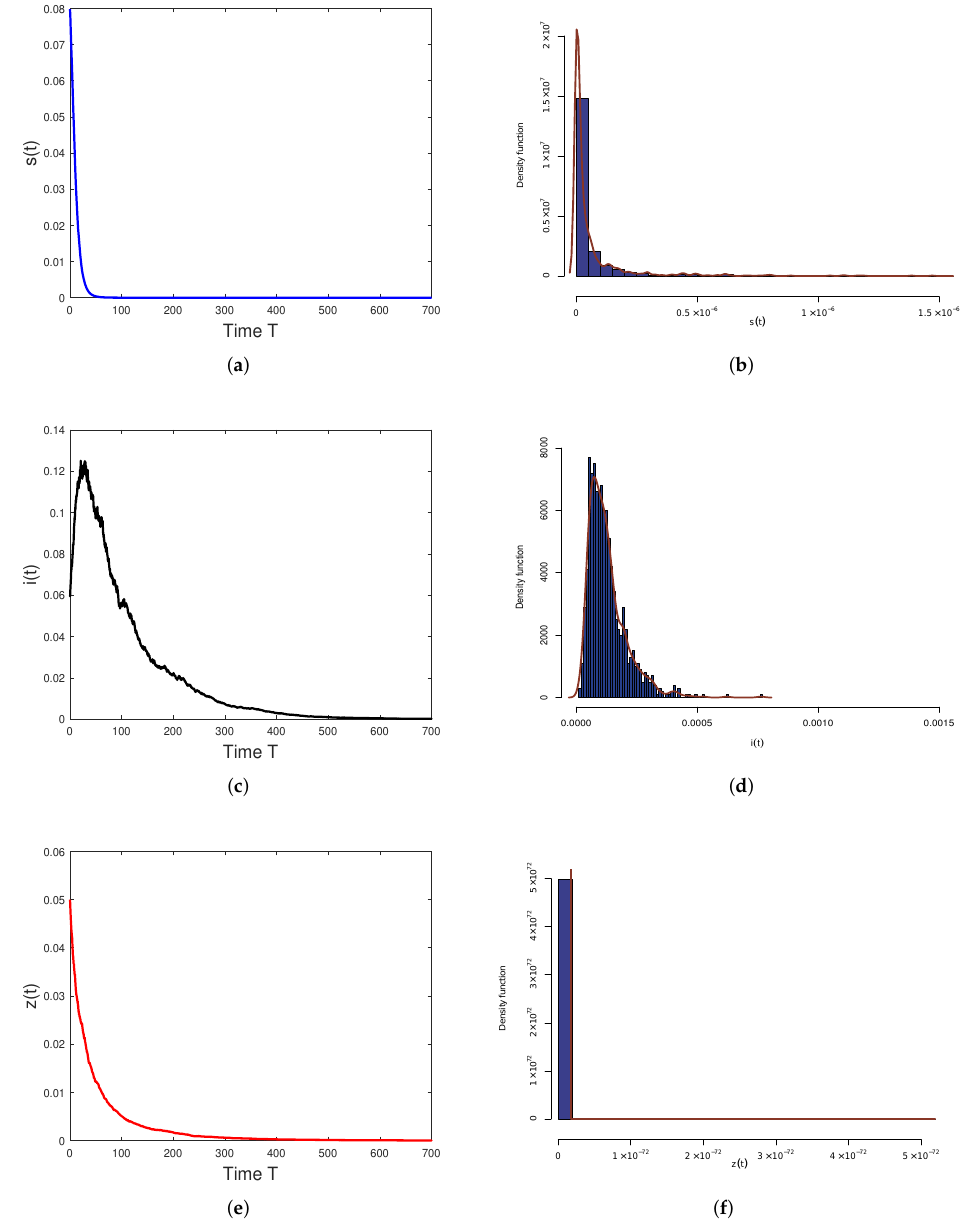
Figure 2. Susceptible phytoplankton s ( t ) , infected phytoplankton i ( t ) , and zooplankton z ( t ) ex- ponentially tend to zero with probability one, when the condition a − σ of Theorem 2 is not satisfied. Parameter values are chosen as a = 0.0015, l 1 = 0.01, l 2 = 0.05, b 1 = 0.0067, n = 0.21, b 2 = 0.00775, σ 1 = 0.012, σ 2 = 0.02, and σ 3 = 0.013, respectively. The initial value is ( 0.08,0.06,0.05 ) . ( a – f ) denote the evolution of a single path and the probability density curve (based on the 1000 simulations) of s ( t ) , i ( t ) , and z ( t ) ,